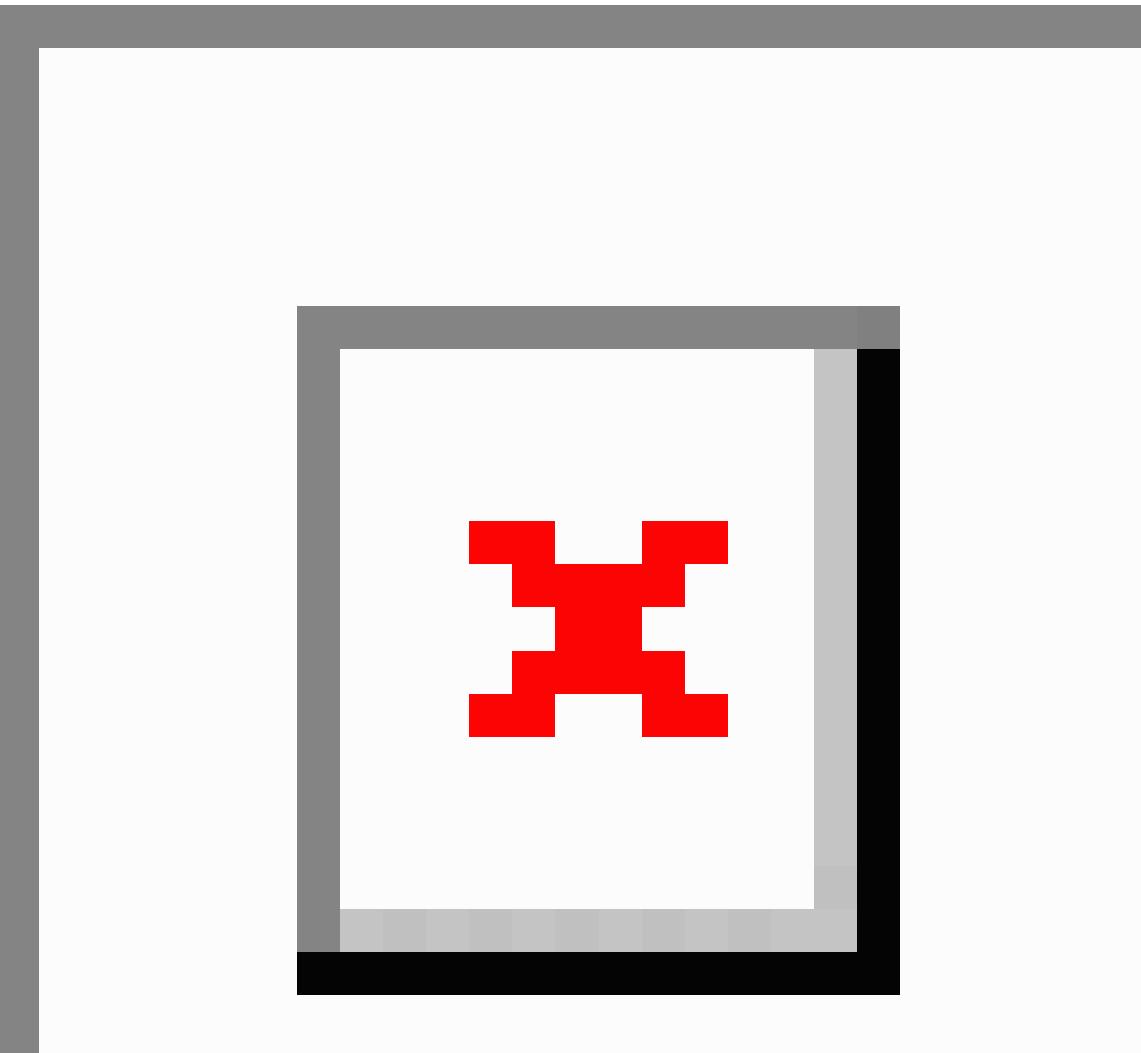
Figure 2. Comparison of COVID-19 survey results between participants from different regions of origin (Veneto vs Campania) for Questions 1-3